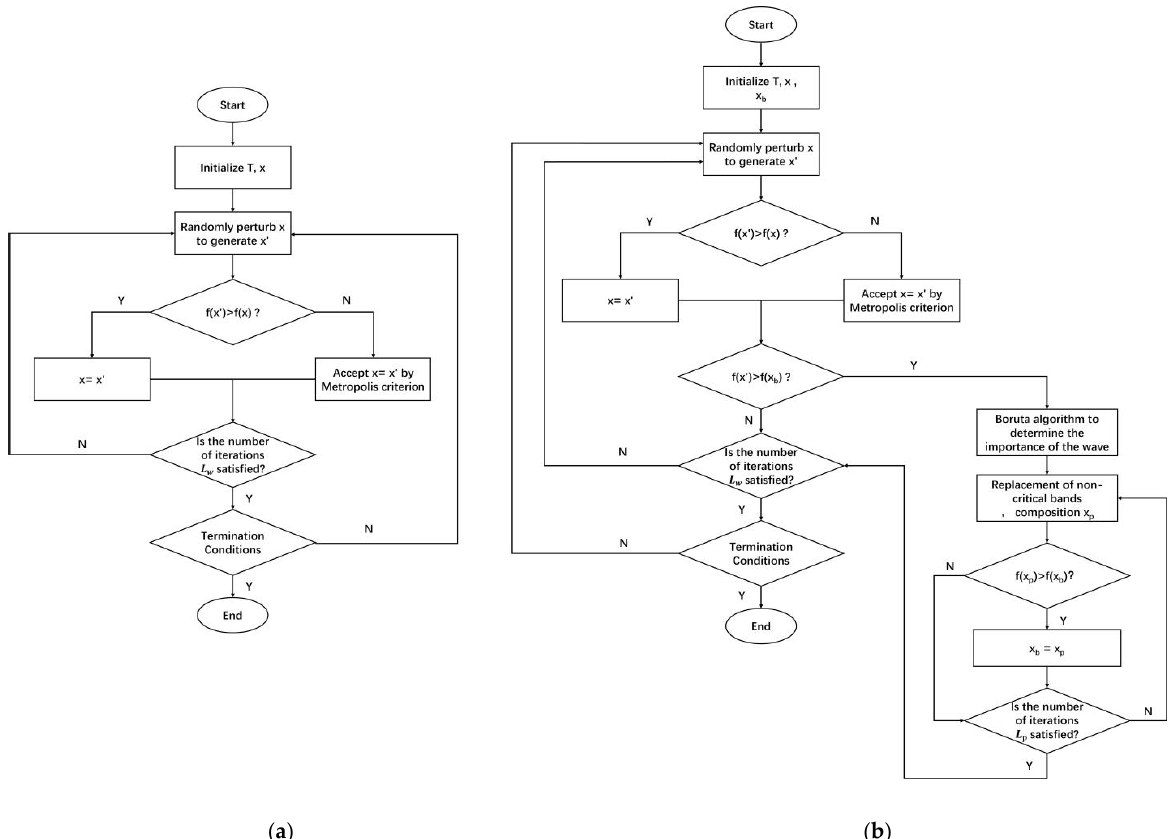
Figure 2. Algorithm flow chart ( a ) Original SA ( b )